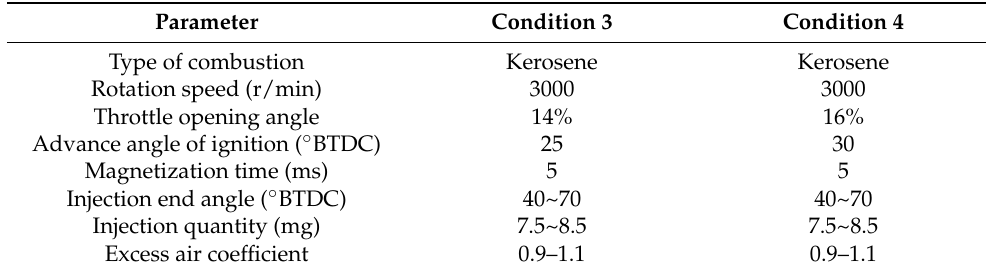
Table 7. Ignition parameters under low-load conditions.